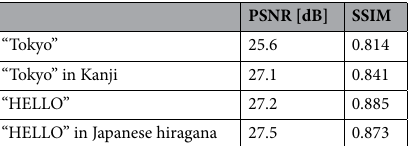
Table 3. PSNR and SSIM in experiments of drawing English and Japansese word.